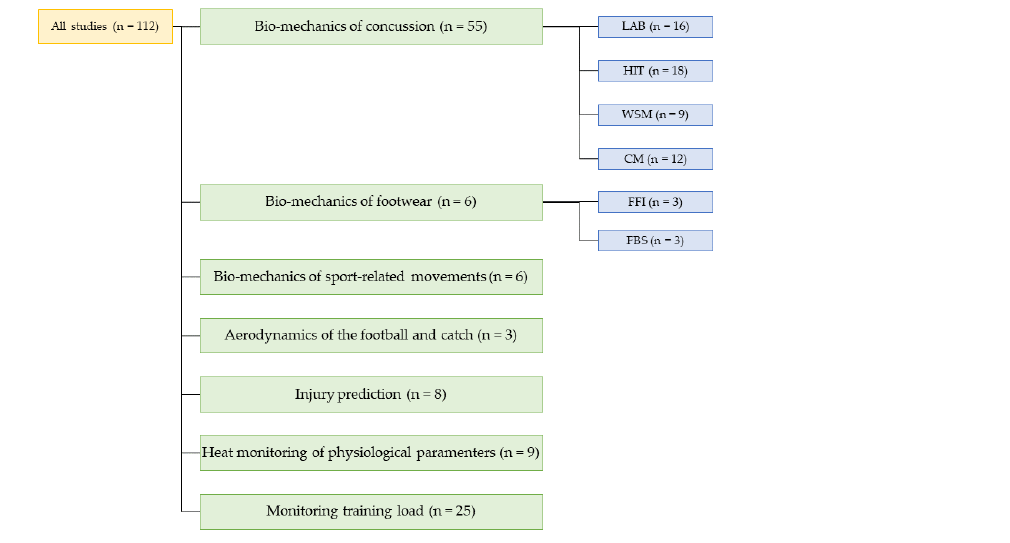
Figure 3. Tree chart of the distribution of studies into categories and